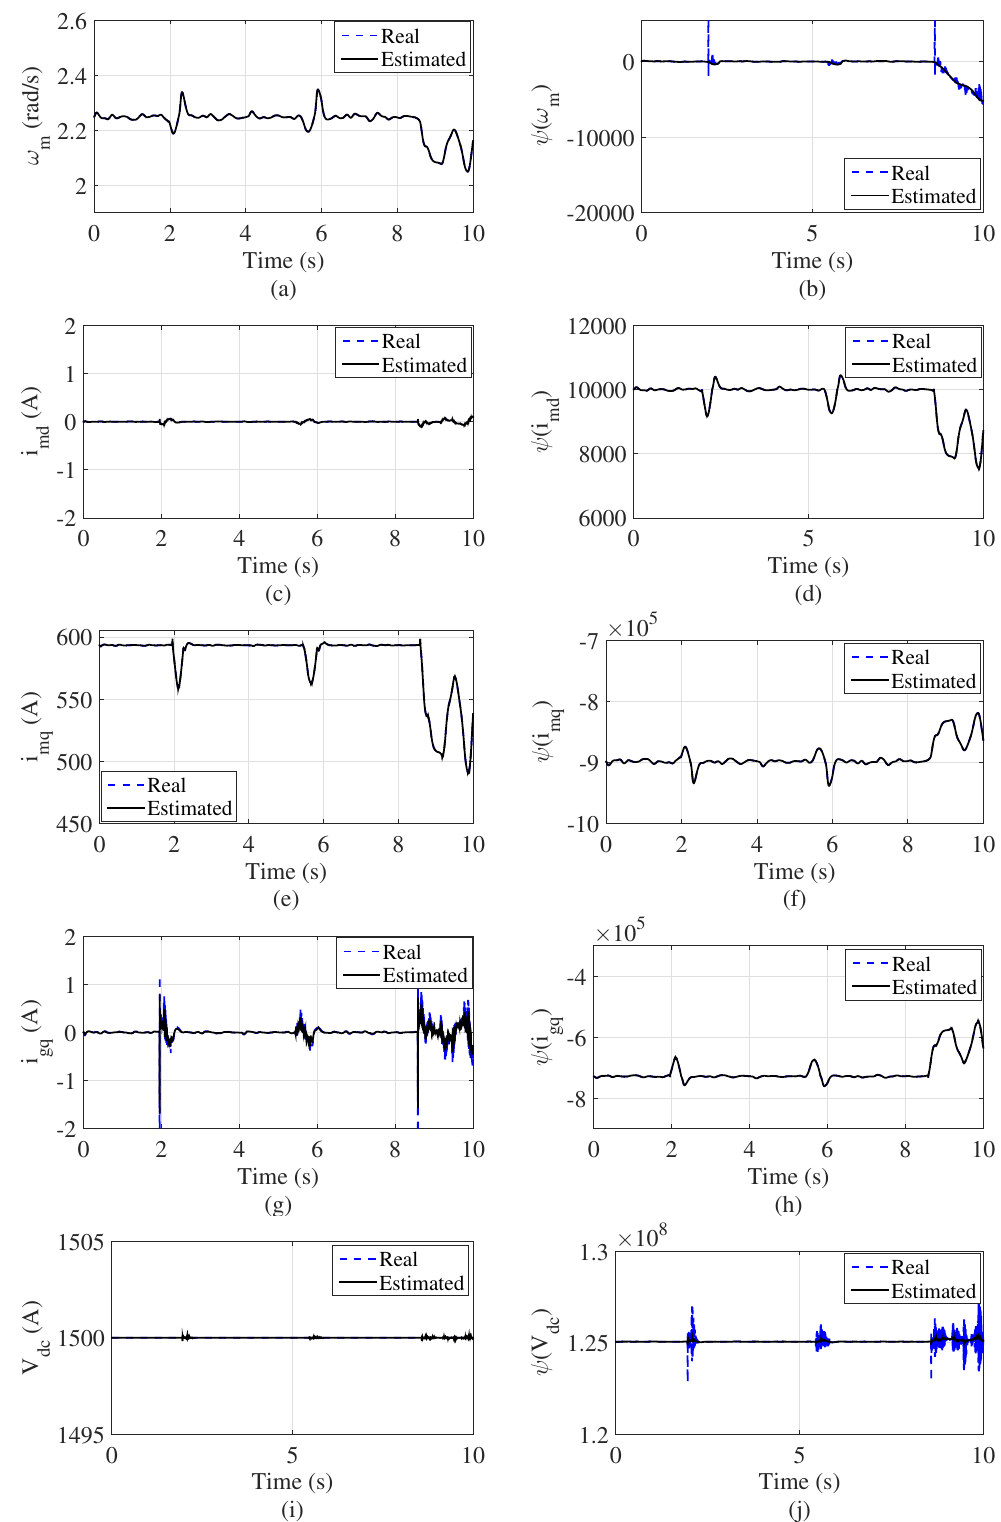
Figure 11. Estimates of states and perturbations to random wind. ( a ) Estimation of mechanical rotation speed ω m . ( b ) Estimation of perturbation term Ψ ( ω m ) . ( c ) Estimation of i md . ( d ) Estimation of perturbation term Ψ ( i md ) . ( e ) Estimation of i mq . ( f ) Estimation of perturbation term Ψ ( i mq ) . ( g ) Estimation of i gq . ( h ) Estimation of perturbation term Ψ ( i gq ) . ( i ) Estimation of V dc . ( j ) Estimation of perturbation term Ψ ( V dc )